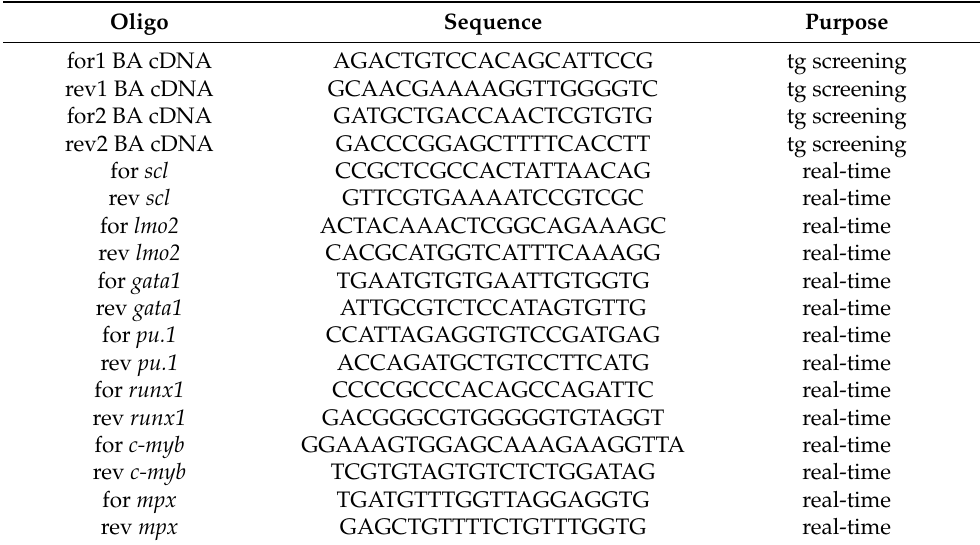
Table 1. List of primers used for Real Time PCR